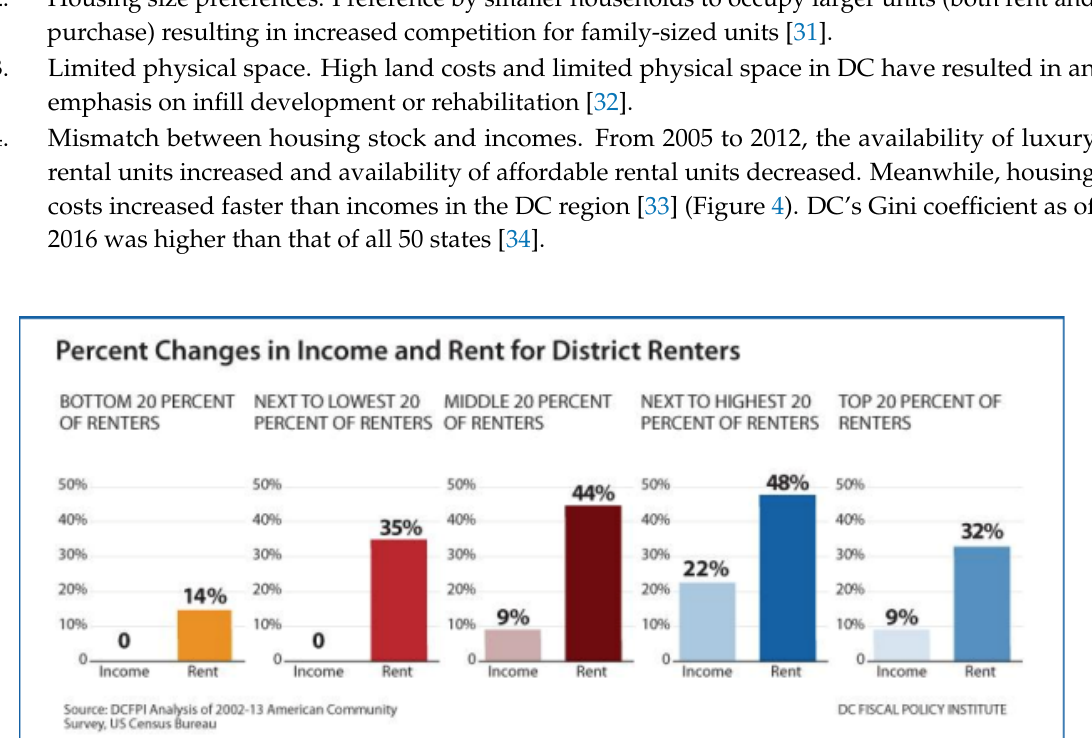
Figure 4. In Washington, DC, housing costs have outpaced household income from 2002 to 2013. Source: [35].